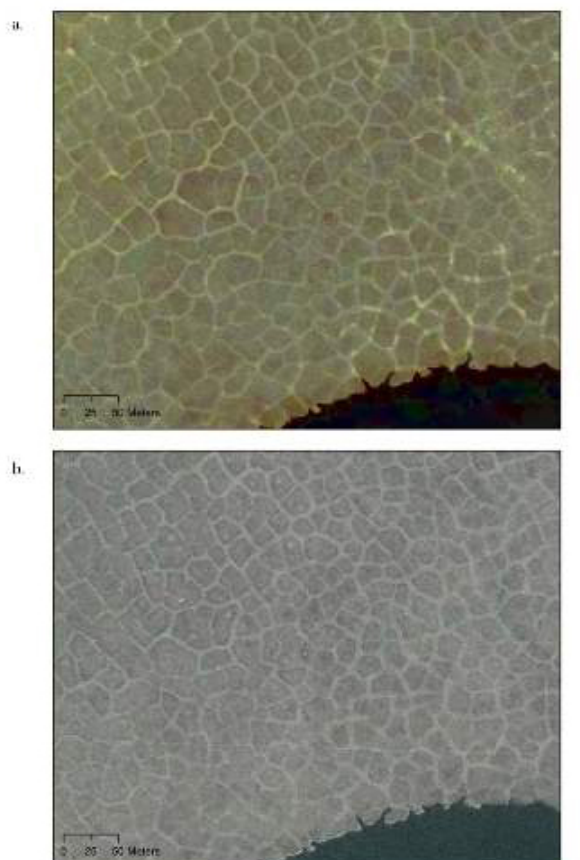
Fig. 8. A comparison of low-centered polygon structure and habitat as seen in (a) pan-sharpened IKONOS and (b) aerial